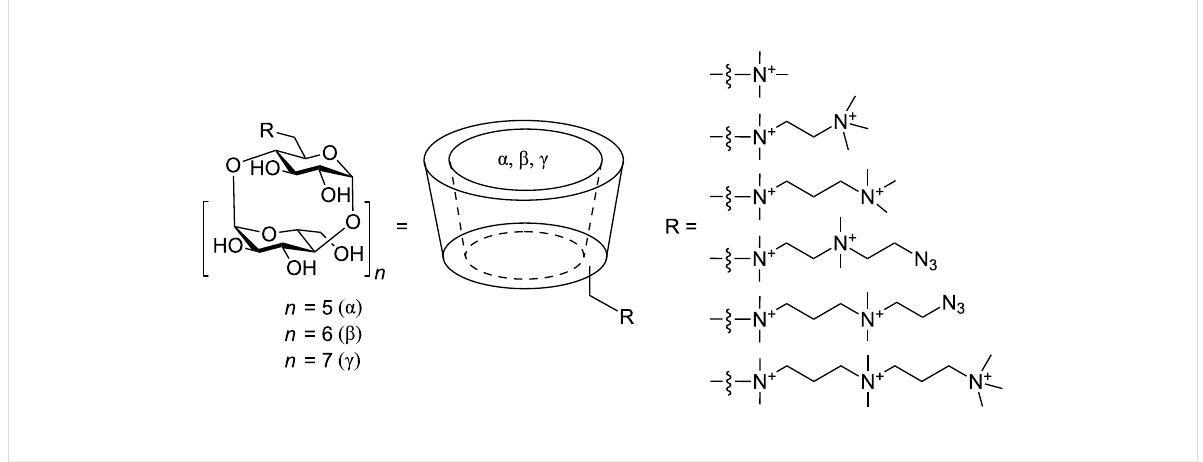
Figure 1: Schematic representation of the prepared sets of permanently charged CD